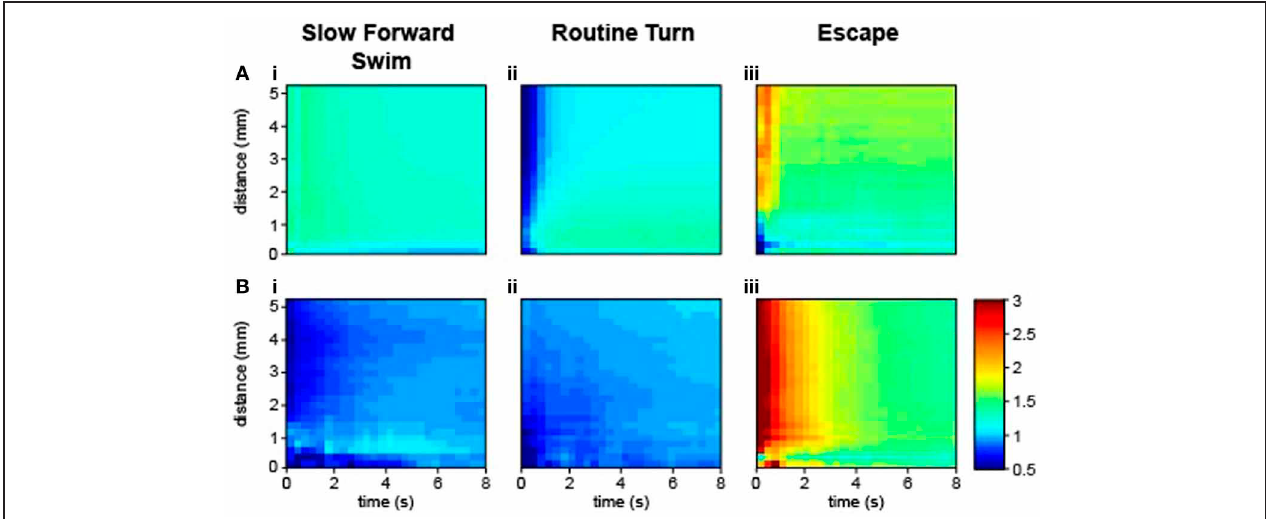
FIGURE 5 | Larva–larva interactions occurred most frequently as sequences of escapes. Transition index for the same larvae (A) and for different larvae (B) . Time is plotted in seconds from the time of initiation of the first movement. Distance is plotted from the core